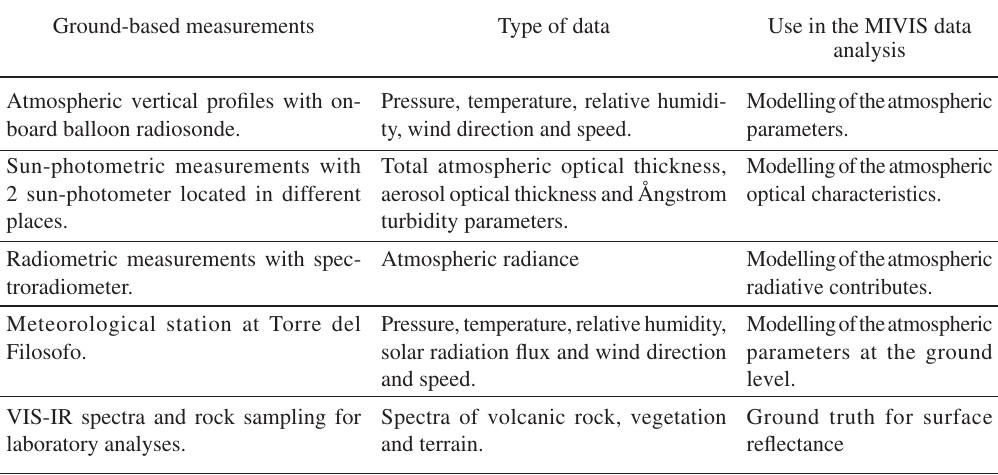
Table III. MVRSS « Sicily 1997 » campaign ground based measurements (Buongiorno et al ., 1999). Ground-based measurements Atmospheric vertical profi les with on- board balloon